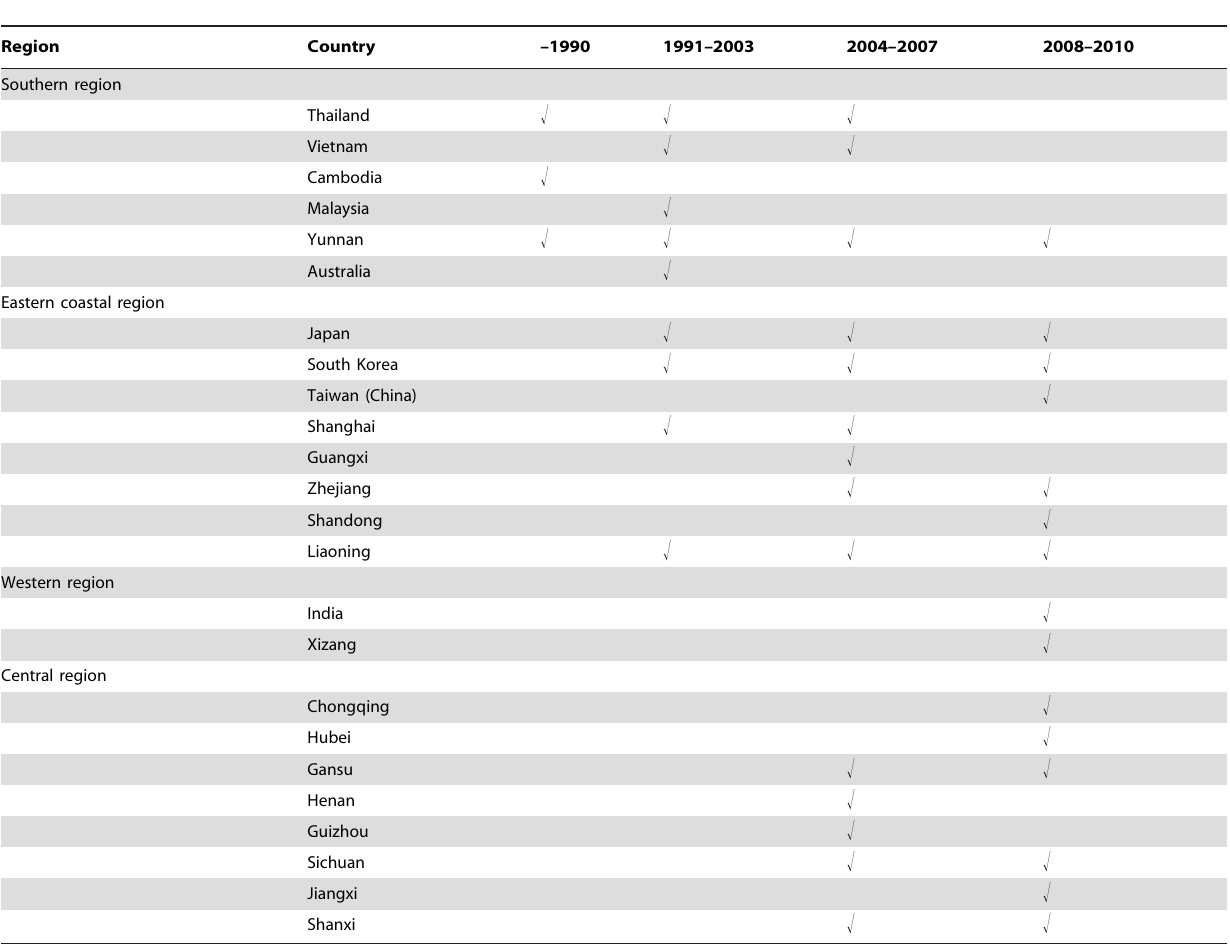
Region Country –1990 1991–2003 2004–2007 2008–2010 Southern